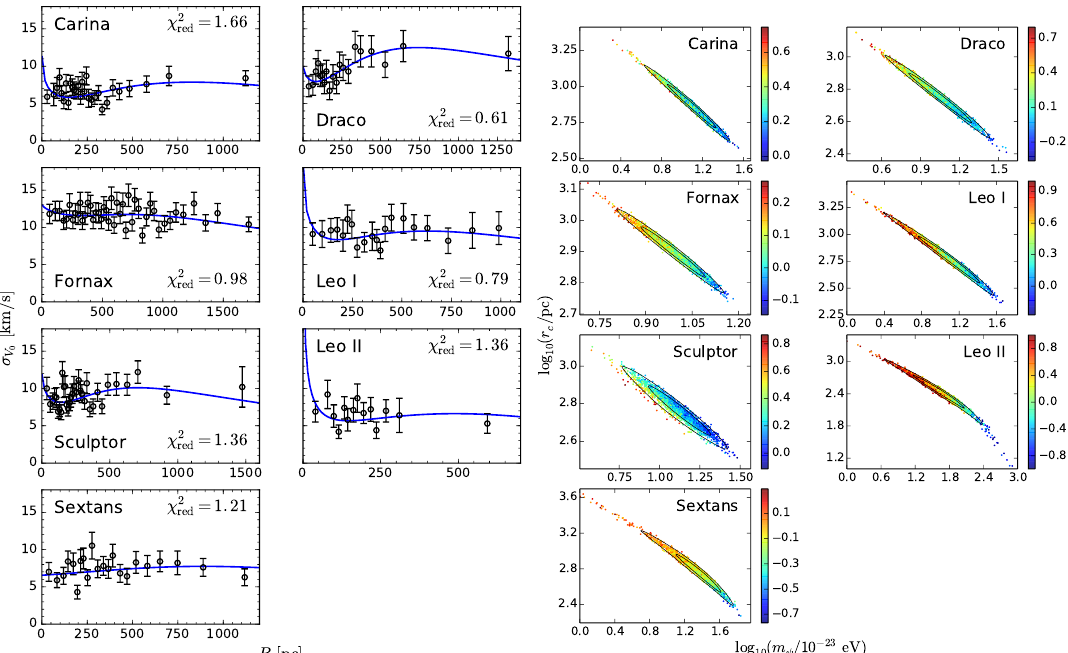
Figure 23. Left panels : best-fit models (blue lines) of the velocity dispersion profile in the FDM scenario for a sample of Milky Way dwarf satellites. Right panels : corresponding core radius-mass relation for each dwarf galaxy sampled from the posterior distribution. The figures are from [502].